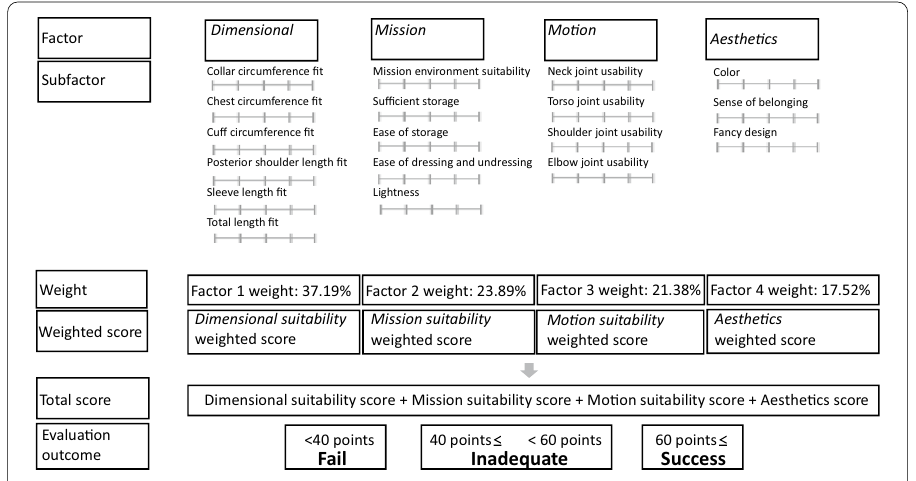
Fig. 2 Quantitative evaluation system for subjective evaluation (5-point Likert scale)